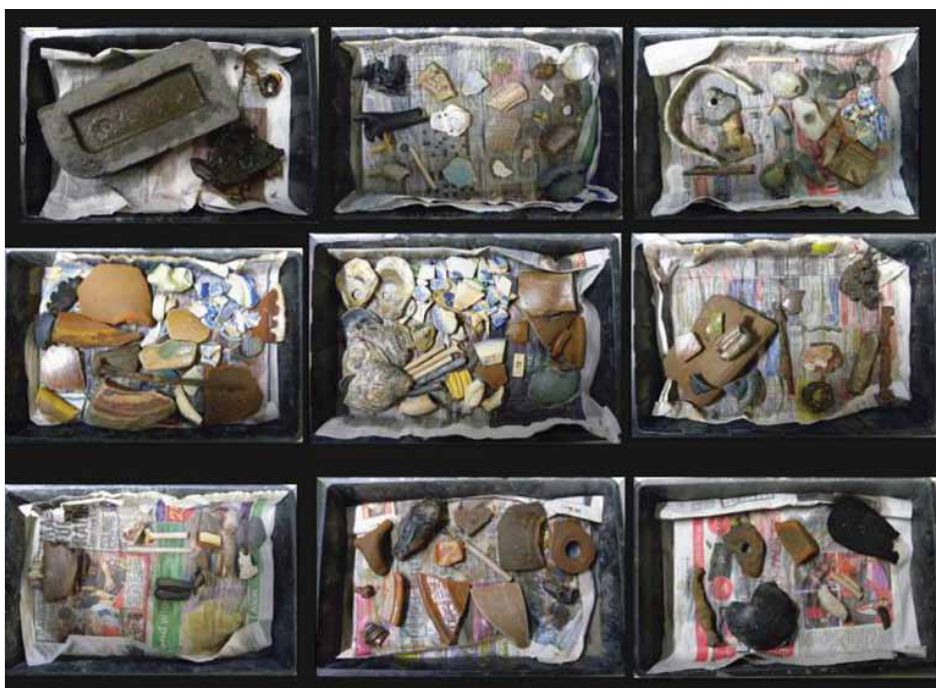
Fig. 3: Artefacts from the ‘River Archaeology Project’ (photo N.